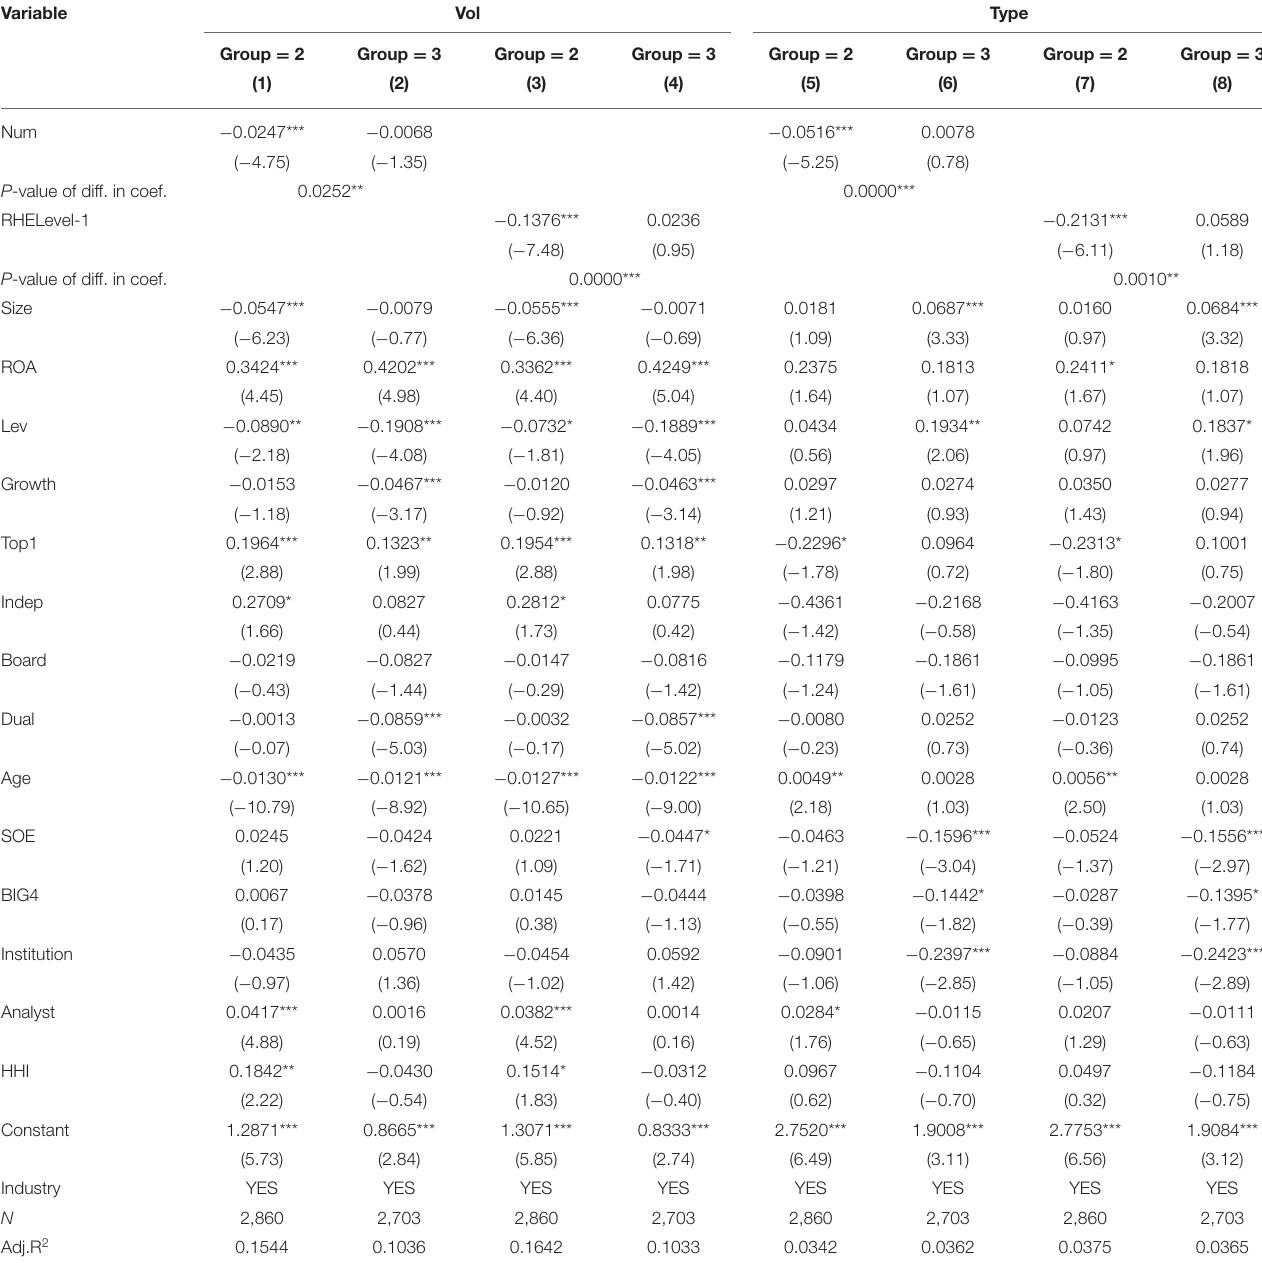
TABLE 5 | Impact of COVID − 19 and law environment on management earnings